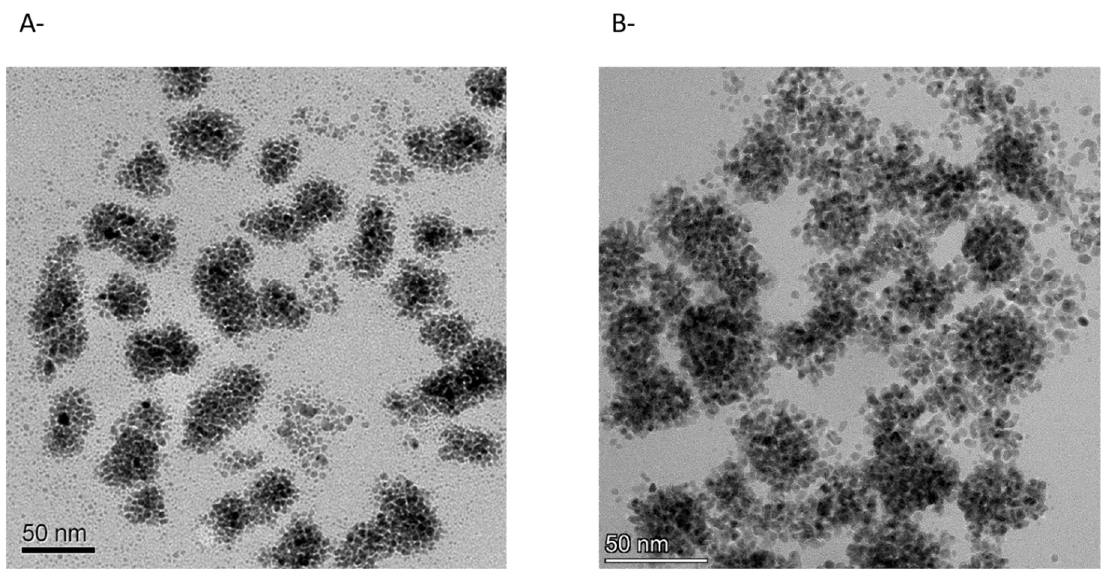
Figure 2. TEM micrographs of i -Pd(OAc) 2 (TPPTS) 2 : ( A ) Before reaction; ( B ) After 24 h of reaction.